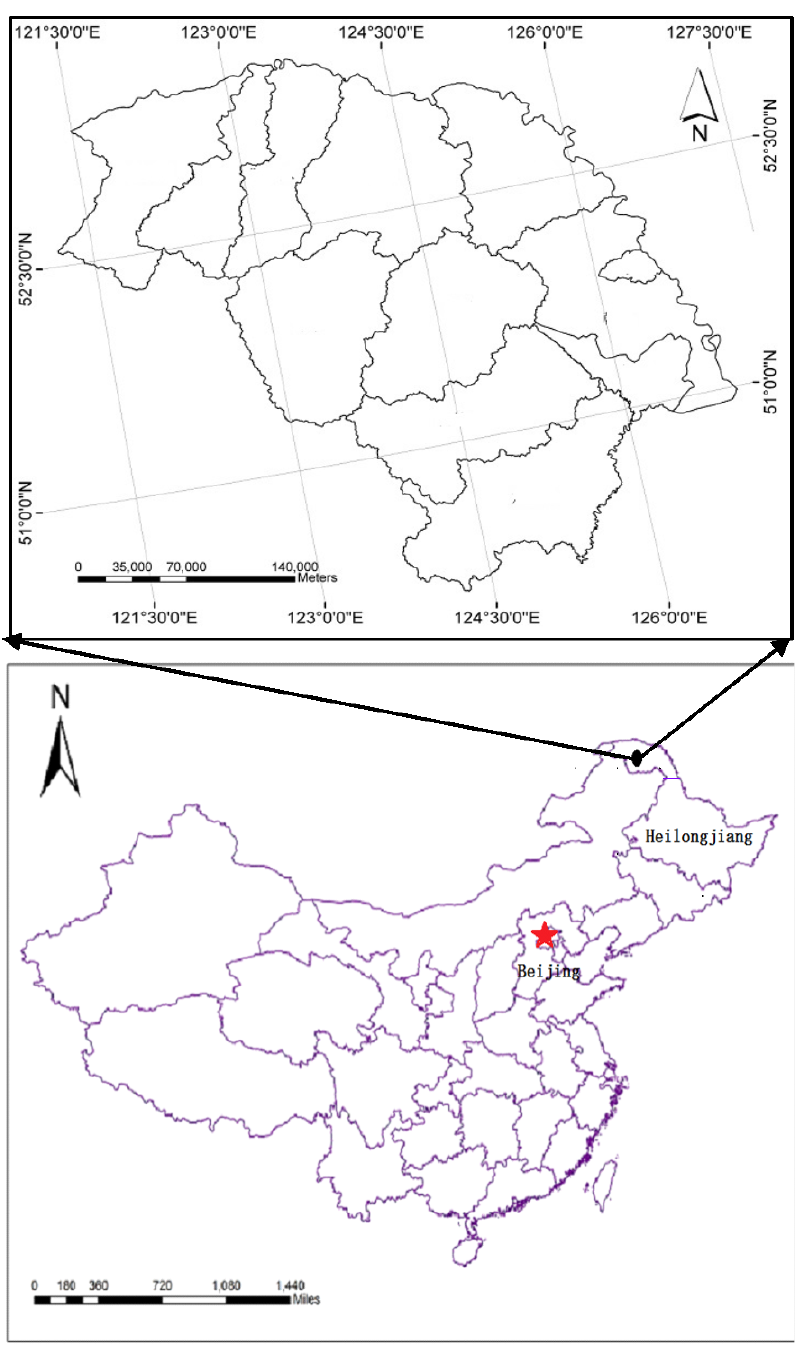
Figure 1. Location of the study areas in Heilongjiang province, northeastern